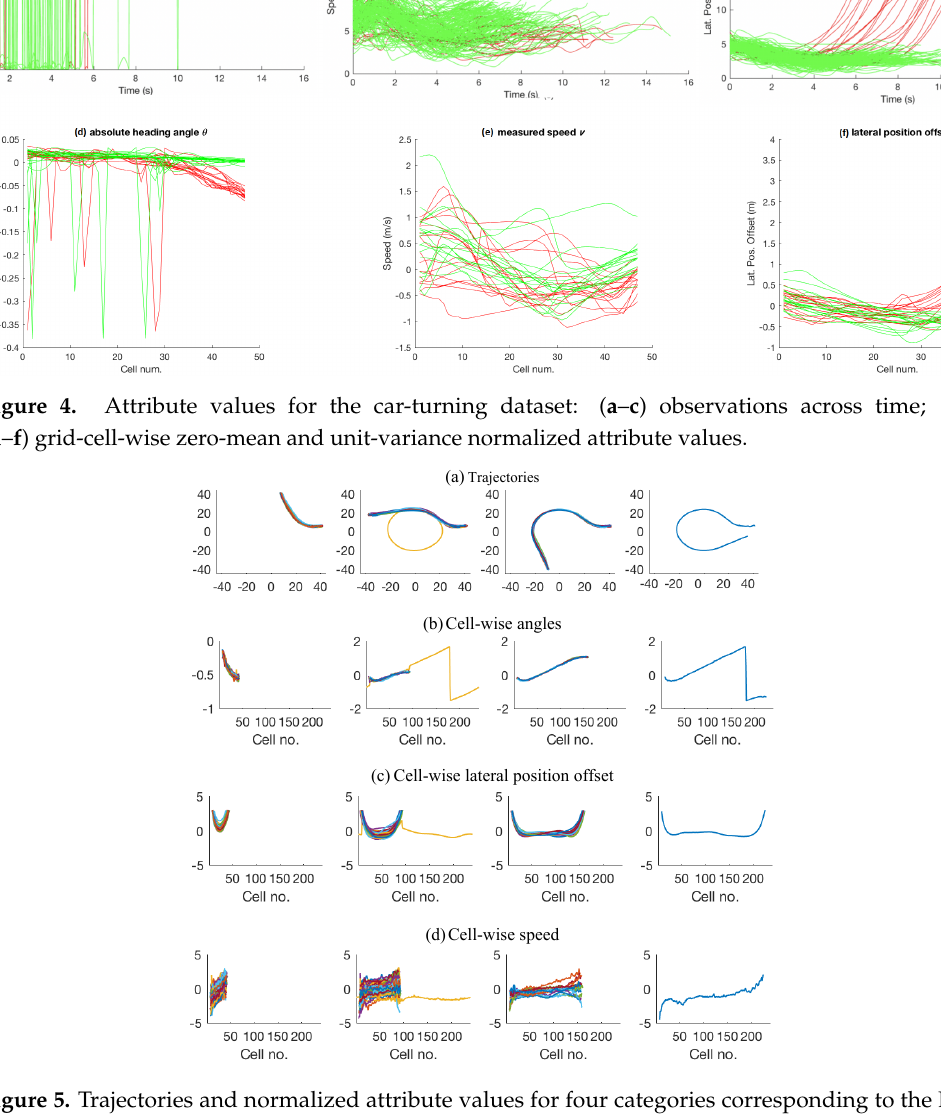
Figure 5. Trajectories and normalized attribute values for four categories corresponding to the East entrance in the roundabout dataset. Note that, only one u-turn trajectory exists (fourth column) in the whole dataset, which makes intuitive sense as vehicles rarely use roundabouts for performing u-turns compared to traffic exiting at first, second or third exits (with respect to any entry point). Similarly, second column of the figure includes one trajectory where a vehicle enters from East, and takes one complete circle around the roundabout, before finally exiting at the